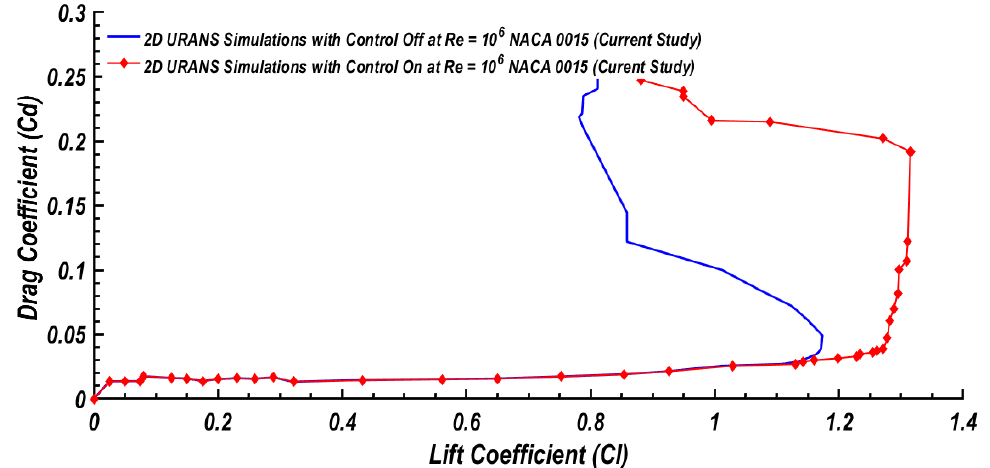
Figure 29. Airfoil drag coe ffi cient as a function of angle of attack at chord Re = 1 Million for control-o ff and control-on cases. Published numerical results and experimental data are also shown for